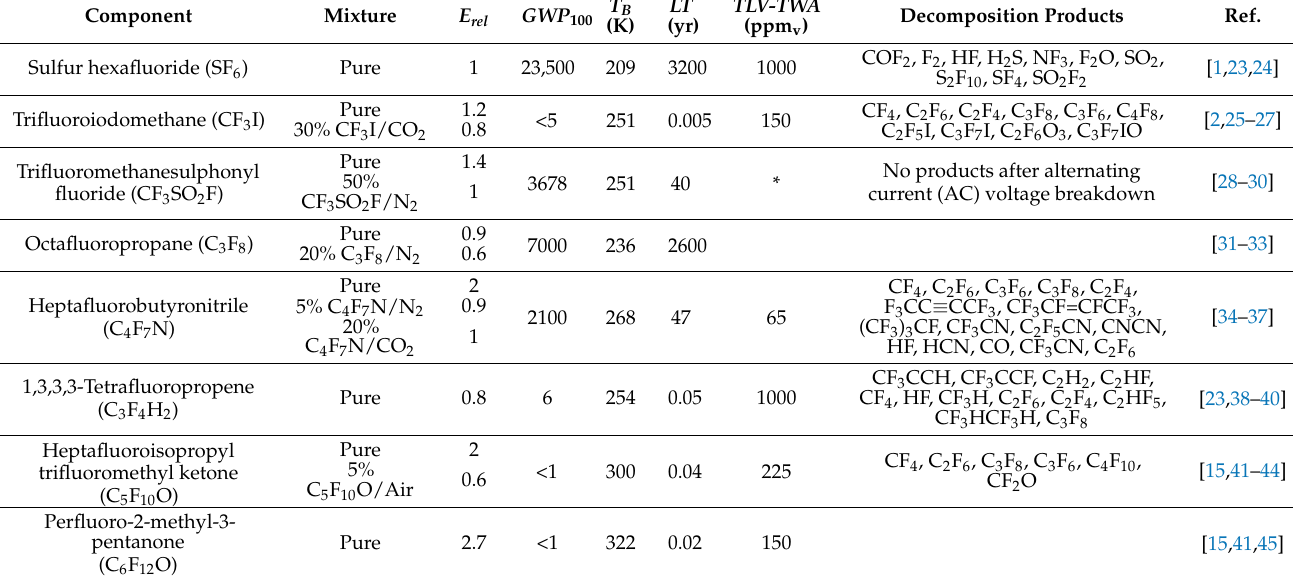
Table 2. Relative breakdown strength ( E rel ), global warming potential values in a 100-year horizon ( GWP 100 ), boiling point ( T B ), toxicity threshold limit values–time weighted average ( TLV-TWA ), and decomposition products of the main researched alternative gas or gas mixtures to replace SF 6 in medium and high voltage